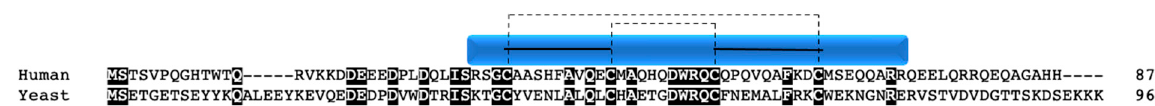
Figure 9. COA4/CHCHD8. Alignment of human and yeast COA4 protein sequences. Black boxes indicate conserved residues. Human sequence annotation is as follows: Blue box indicates the CHCH domain. Solid black lines indicate the twin CX 9 C motif. Dashed lines indicate the cysteine pairs that form structural disulfide bonds.